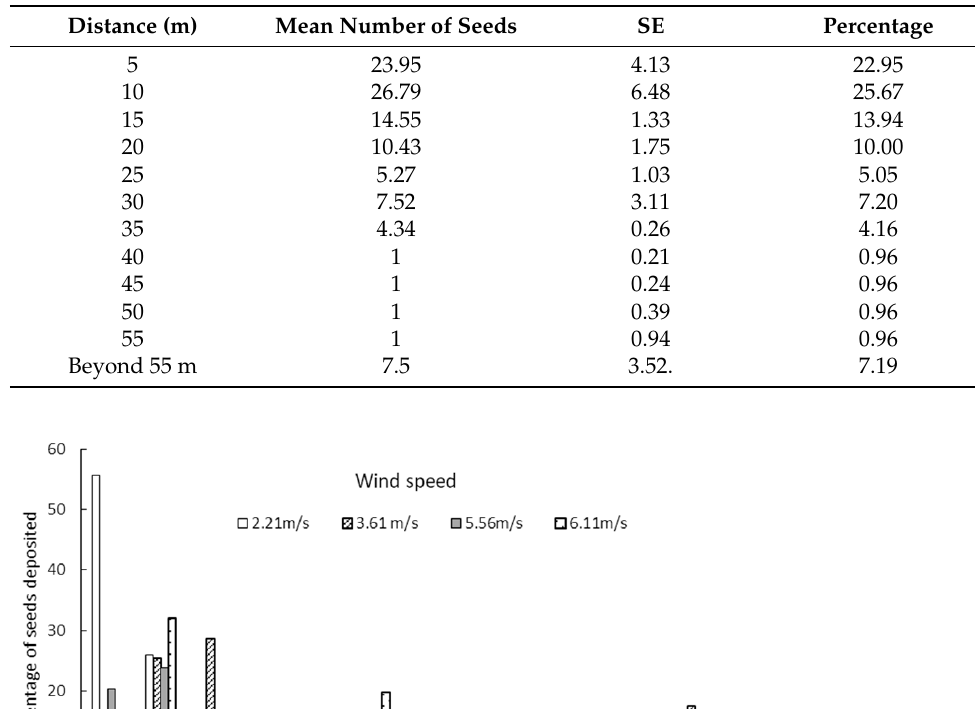
Table 1. Mean ± SE of number of seeds by distance interval (bin, (m)) when all seed dispersal data were pooled (n = 143). Figure 3. Mean distribution (95% confidence interval) of number of plants in quadrats along six transects at the leeward edge of the Muckaty infestation. These data were used to (a) select the threshold for short-distance dispersal and (b) fit a model to the stem circumference distribution data across transects (y = (9.01 − 0.0003x 2 ) 2 ; F 1, 82 = 29.33, p = 0.00 and R 2 = 26.58). Where y is the log of number of plants, and x is the stem circumference. The invasion front was determined based on smaller stemmed plants towards the stand edge, while the size of larger stems at the stand centre yielded the stand age.